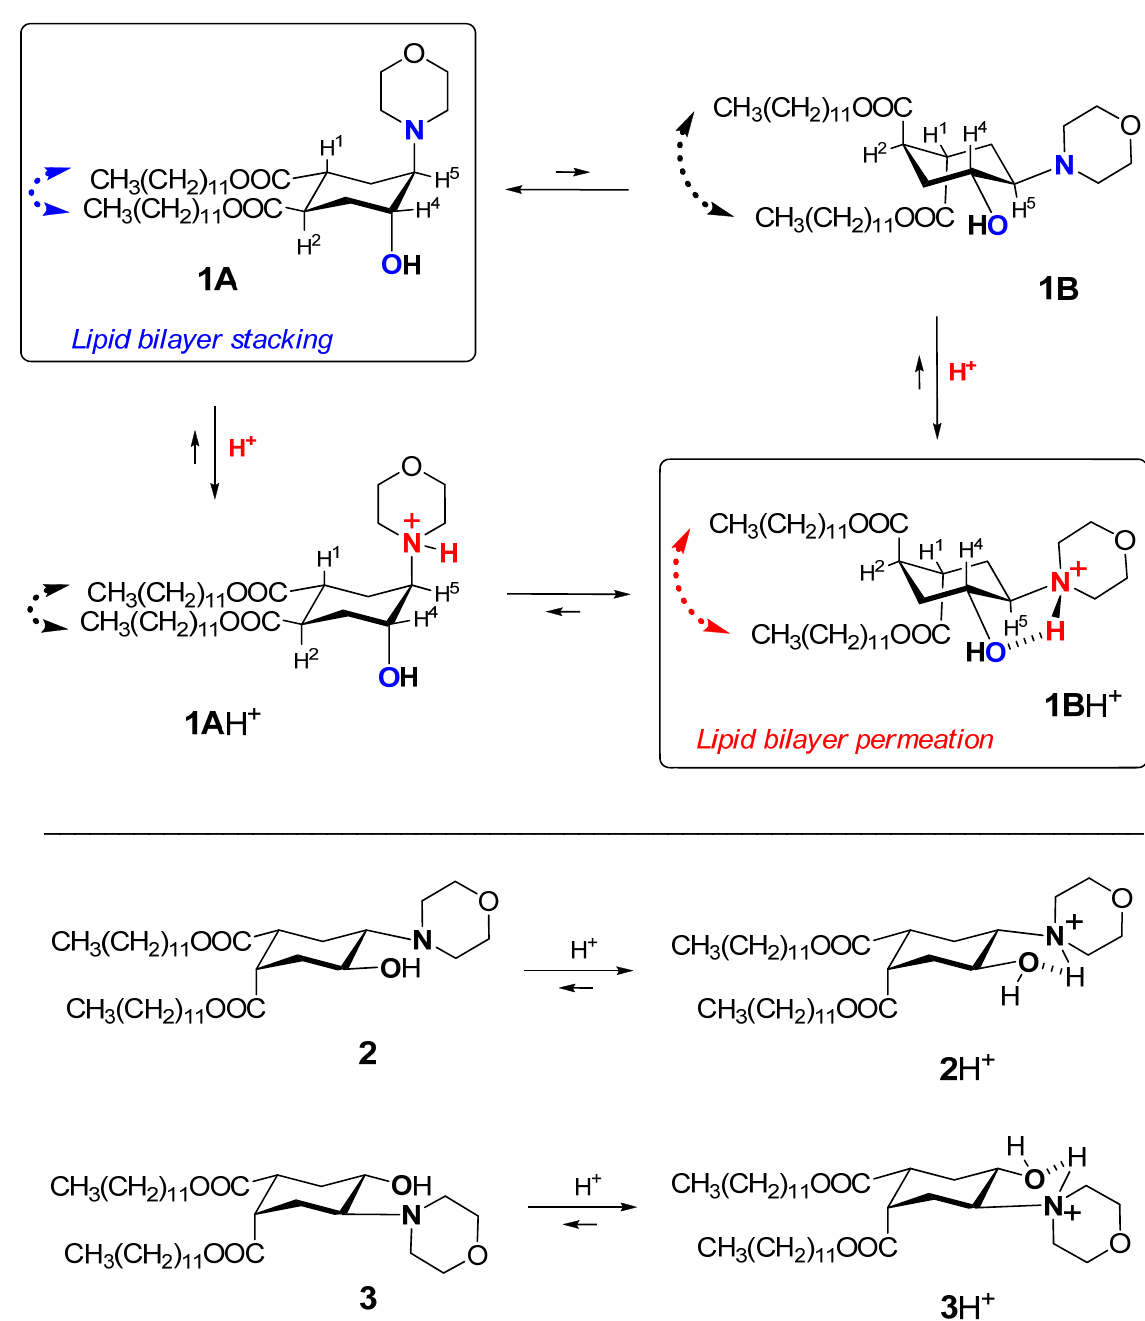
Figure 1. Protonation-induced conformational switch of lipid tails in amphiphile 1 , and an absence of such a switch in amphiphiles 2 and 3